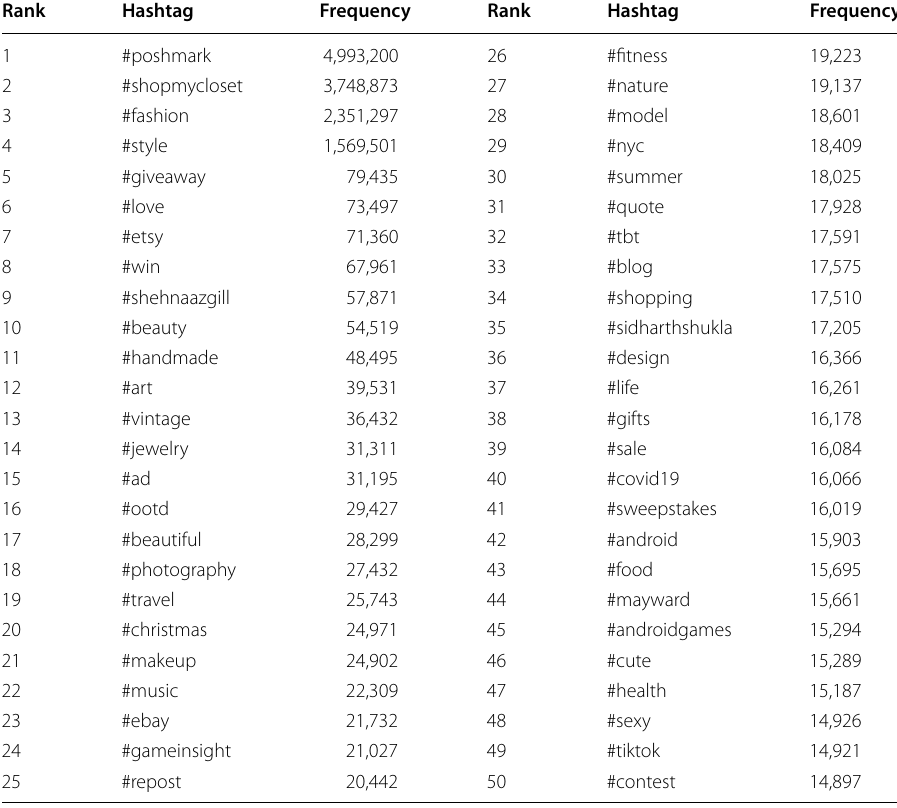
Table 4 Top‑50 popular hashtags from the tweets posted by the young female users interested in